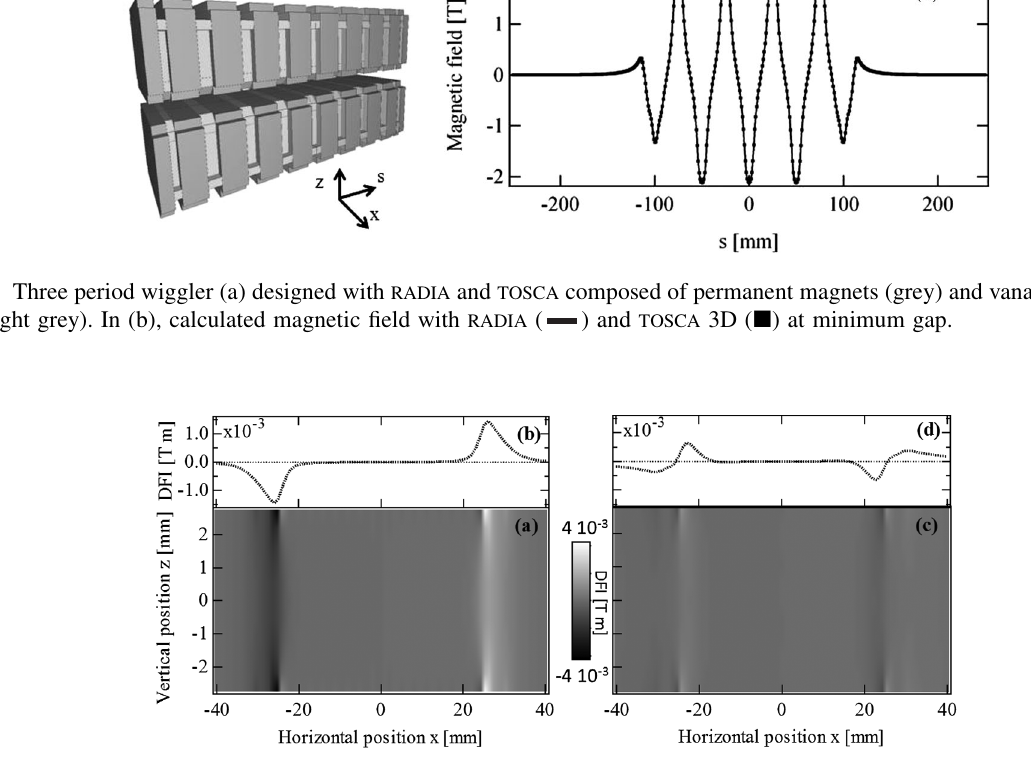
FIG. 3. Calculated 2D DFI (a), median plan ( z ¼ 0 ) DFI (b), calculated 2D DFI added to the calculated vertical field 2D map produced by the magic finger magnets (c), median plan ( z ¼ 0 ) DFI added to the on-axis vertical field produced by the magic finger magnets (d). Calculations are performed with the RADIA code.